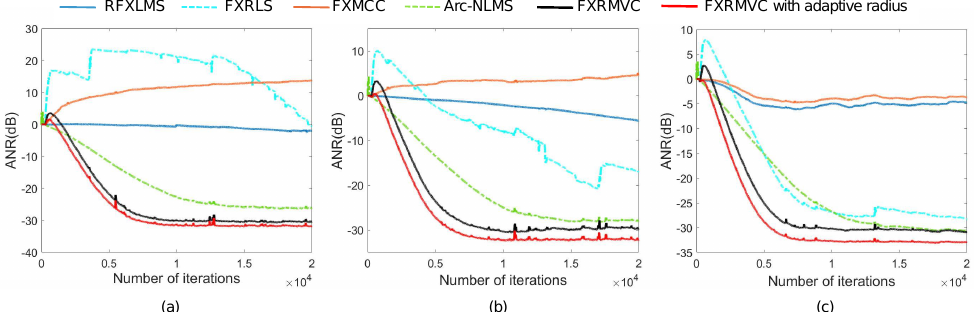
Figure 6. ANR comparison under different impulse noise cases: ( a ) α = 1.2, ( b ) α = 1.4 and ( c ) α =